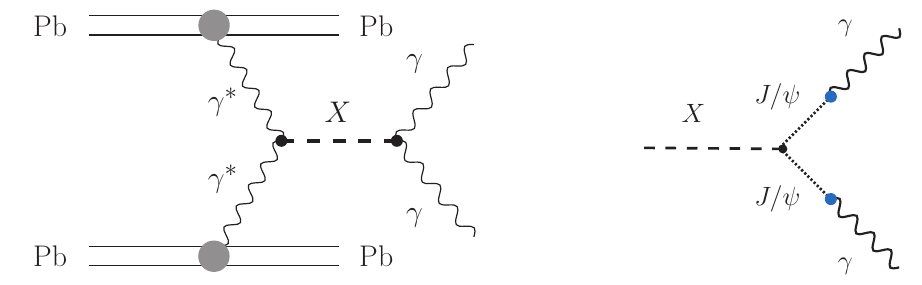
Figure 1. Left: the X -resonance contribution to light-by-light scattering in ultraperipheral heavy-ion collisions (crossed graphs are omitted). Right: the vector-meson-dominance (VMD) mechanism for the two-photon decay.